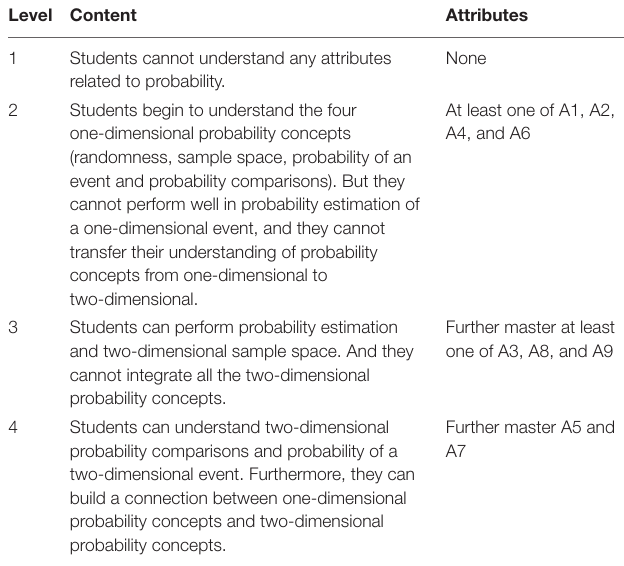
TABLE 6 | Modified learning progression of probability. Level